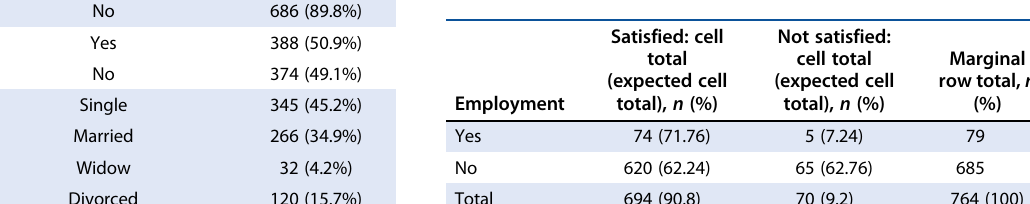
Table 5: Comparison of households ’ satisfaction by